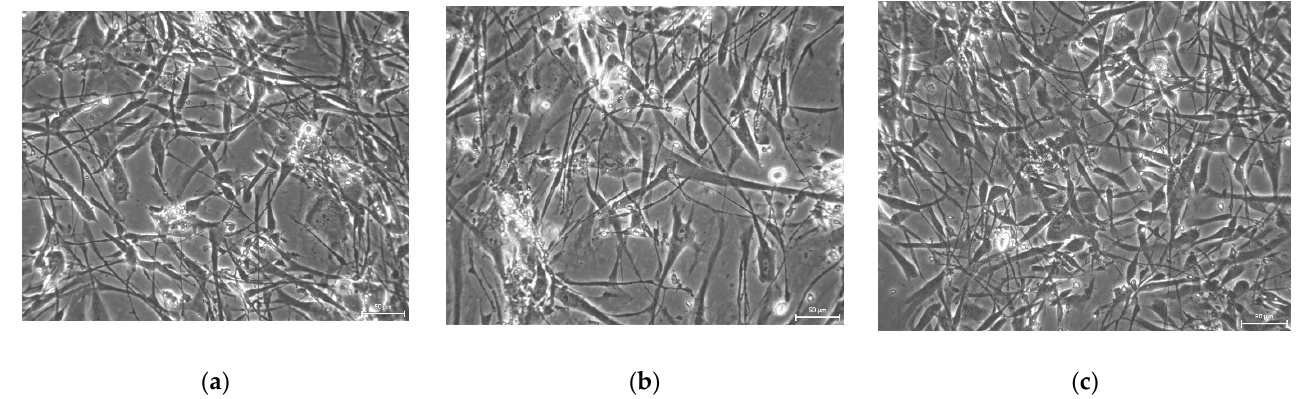
Figure 6. Revived DPSC before differentiation: ( a ) 10% DMSO cryomedium; ( b ) 3% DMSO cryomedium; ( c ) 3% DMSO + 0.1% HMW-HA cryomedium. Scale bar 50 µm.